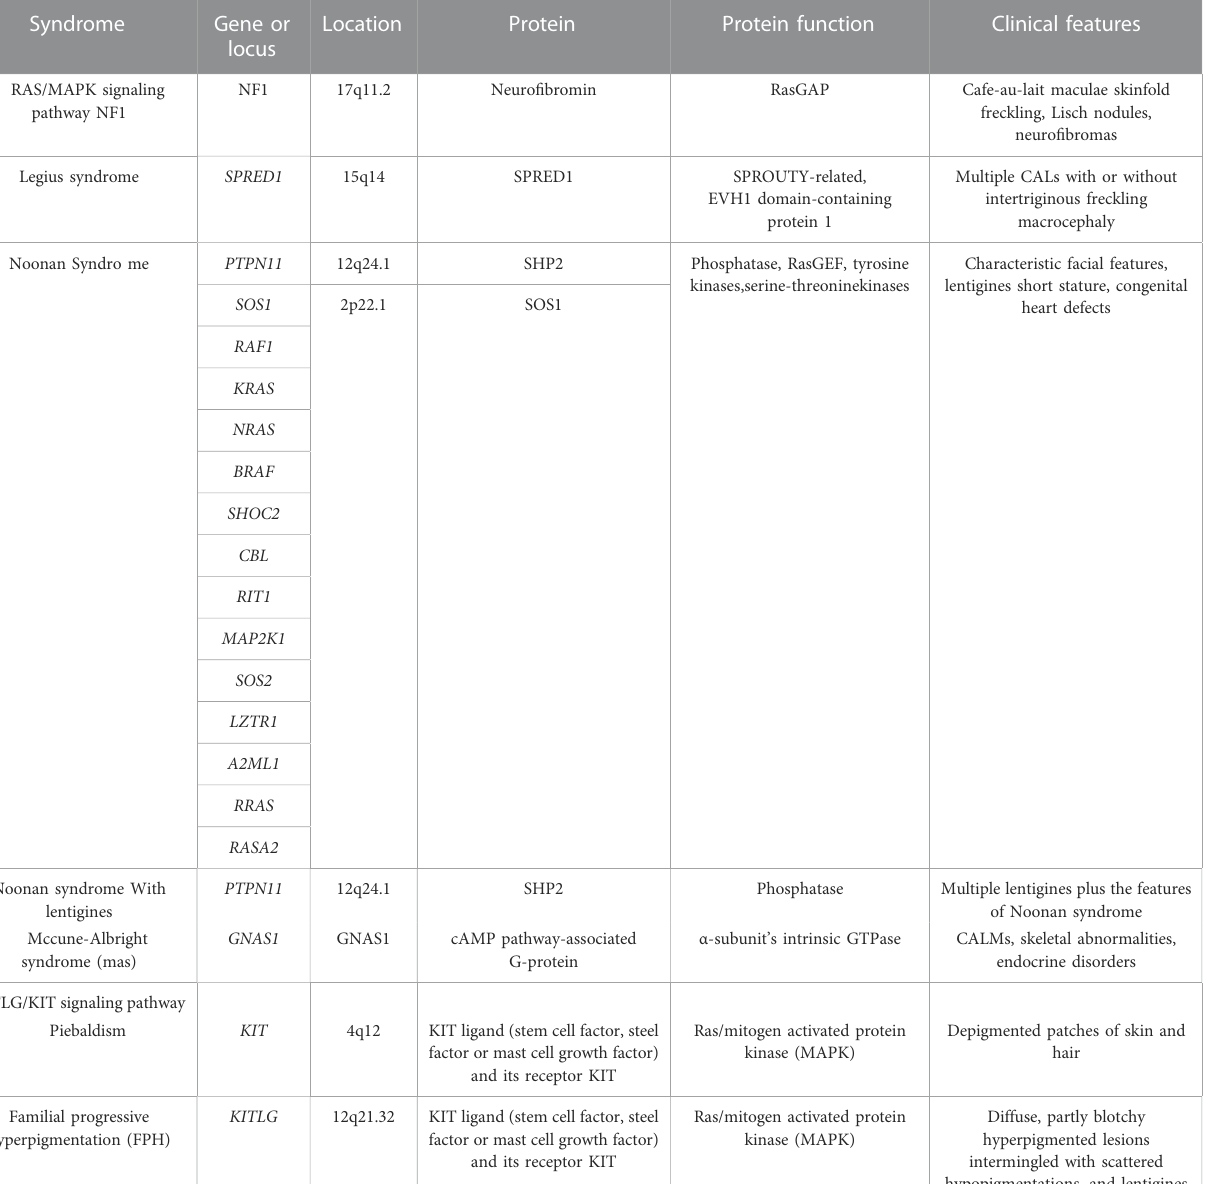
TABLE 3 Different diseases that cause